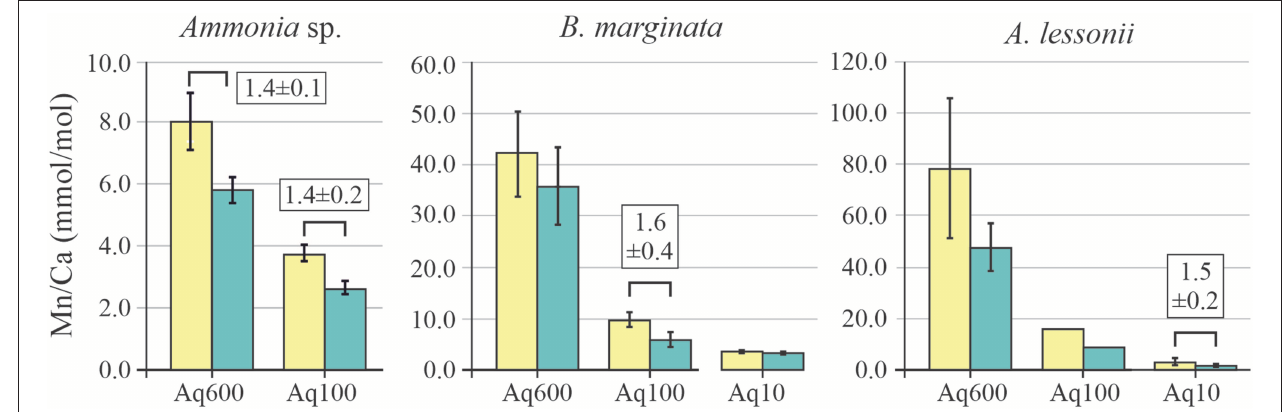
FIGURE 7 | EPMA average peak (Mn/Ca MAX ; yellow) and base (Mn/Ca MIN ; blue) of Mn/Ca of Ammonia sp. T6 (left panel), Bulimina marginata (middle panel), and Amphistegina lessonii (right panel) per treatment with peak factor ( ± SD ). Significant differences ( p < 0.05) between peak and/or base values (e.g., PI and BI) are indicated with brackets, and for these values, peak factors ± SD (E/Ca MAX /E/Ca MIN ) are given (see also Table 3 ). EPMA, electron probe microanalysis. TABLE 5 | Mn/Ca peak (Mn/Ca MAX ) and base (Mn/Ca MIN ) values for Ammonia sp. T6, Bulimina marginata , and Amphistegina lessonii with peak factor (PF; significant values in bold, see Table 4 ) and average values obtained by EPMA analyses (see Table 2 ).